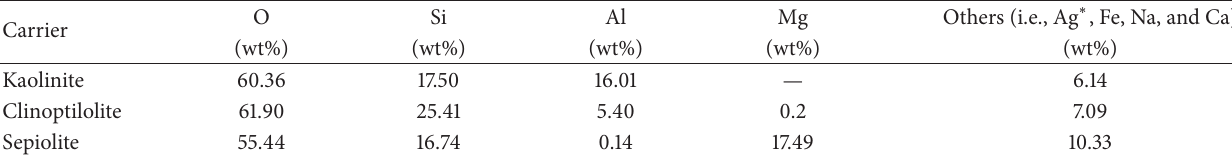
∗ Detailed analysis results are tabulated in Table 2.